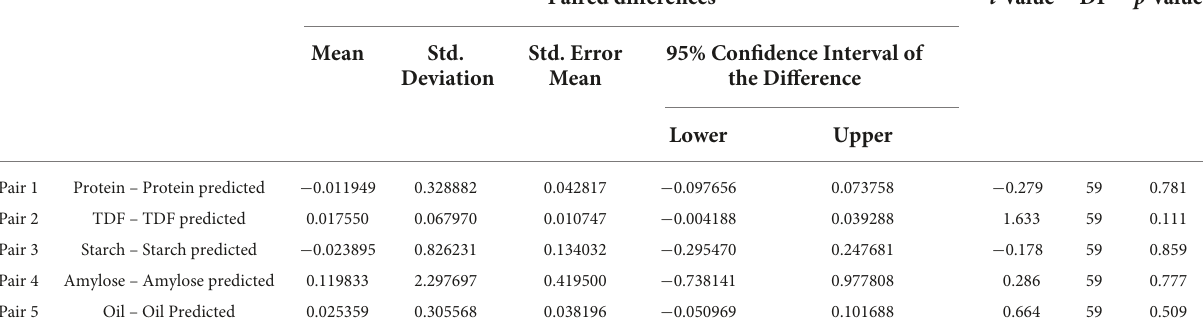
TABLE 4 Results of paired sample t -test between the reference and predicted